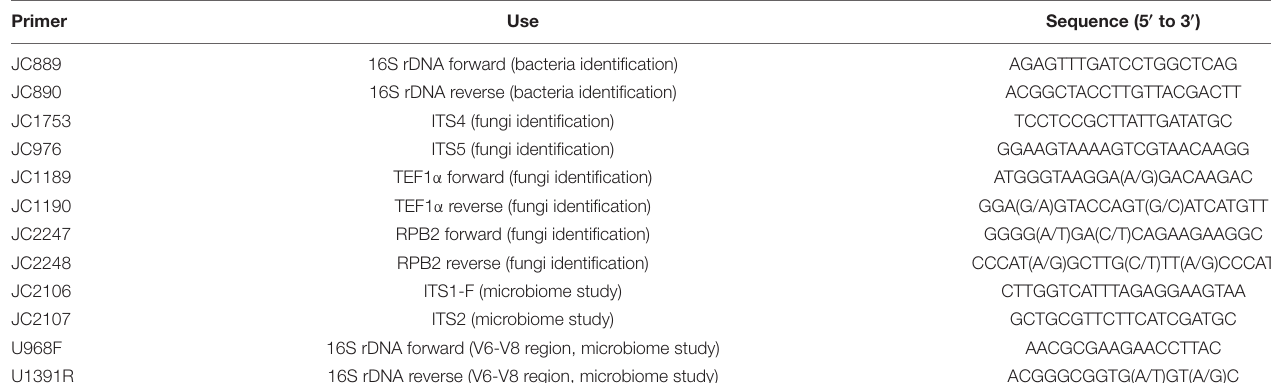
TABLE 1 | Primers used in this